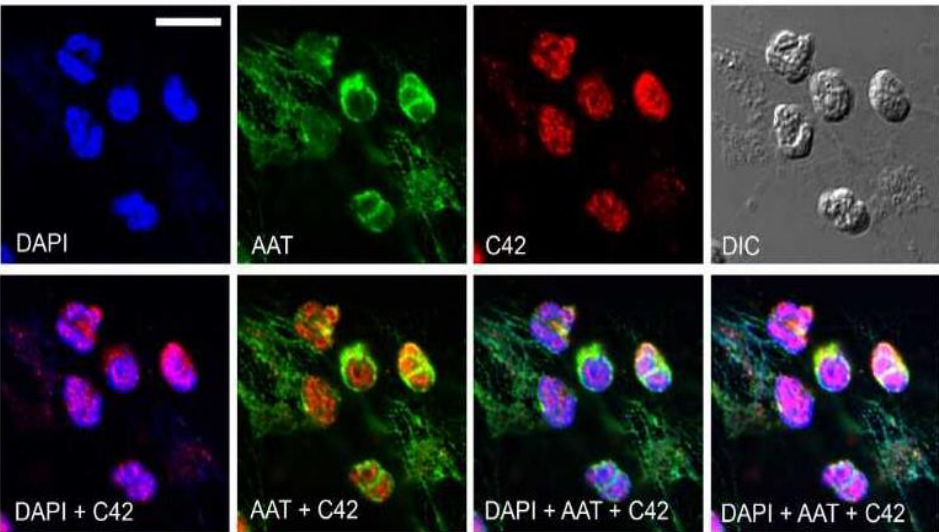
Figure 6. Distribution of the C36 peptide and full-length AAT in NETs from human neutrophils. Double labeling experiment showed very limited co-localization between full length AAT ( green , stained with polyclonal anti-AAT) and C-36 ( red , stained with C42 mAb) patterns in LPS-stimulated neutrophils releasing DNA fibers (NETs). Nuclei and DNA fibers stained with DAPI ( blue ). Two last panels marked as DAPI +AAT +C42, show the same image, but second one is overexposed in blue and red channels to better show DAPI staining and C-36 localization in fine DNA fibers. Scale bar, 10 µ